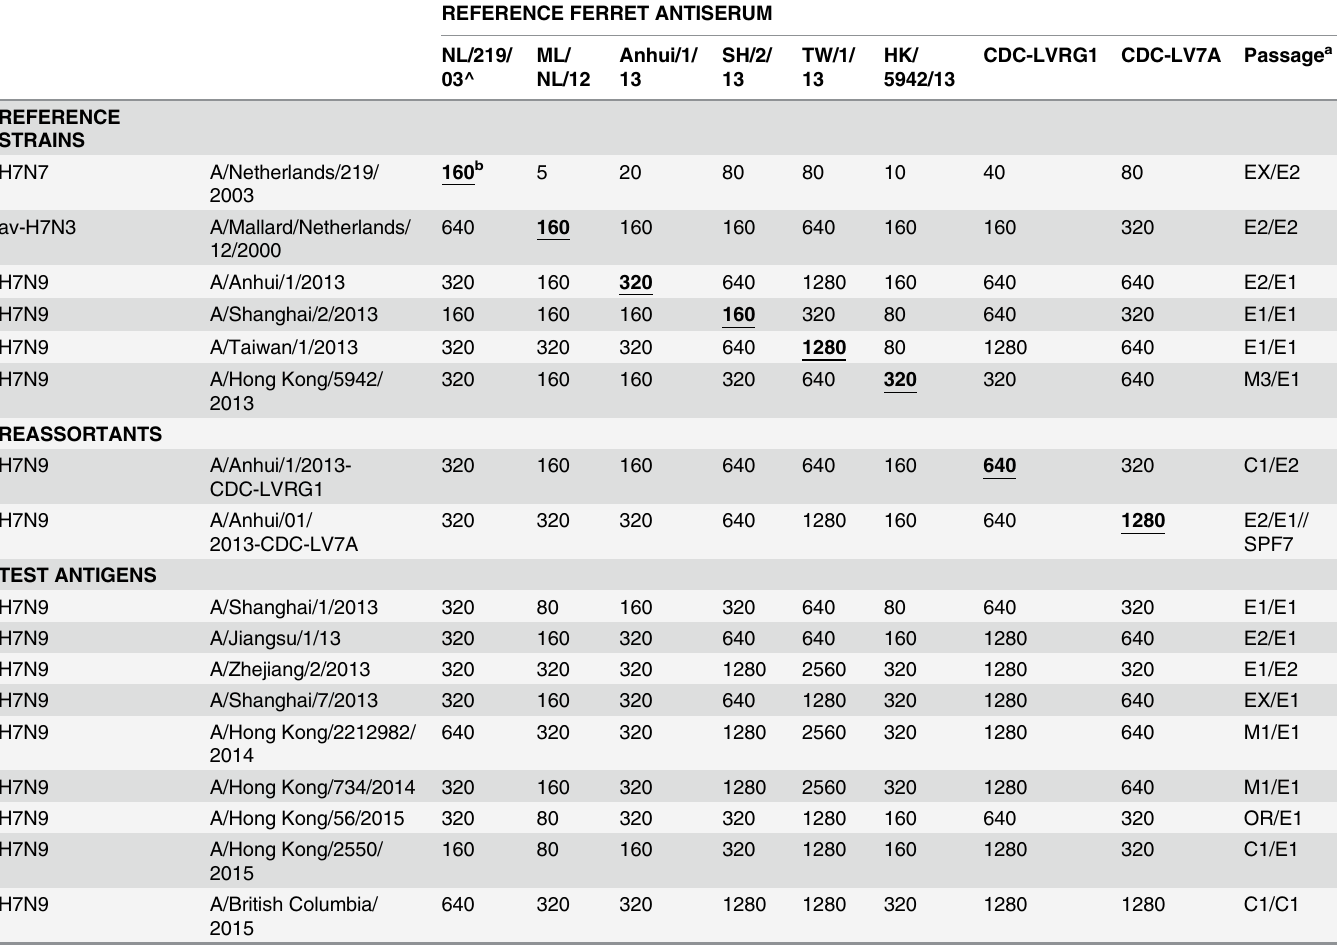
Table 4. Two-way hemagglutination inhibition assay of reference A(H7N9) viruses and LAIV reassortants. REFERENCE FERRET